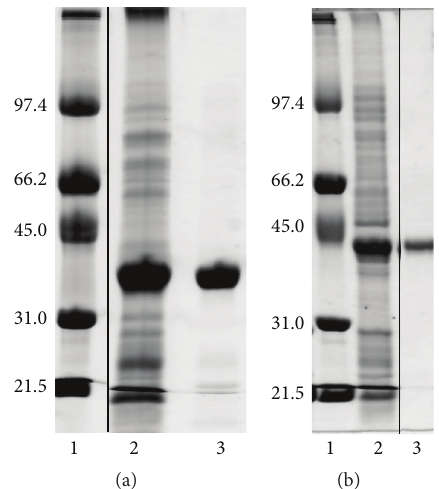
Figure 3: Purification samples of PeiW and PeiP on SDS-PAGE. Gel (a) PeiW; lane 1, molecular weight markers with sizes indicated in kDa, lane 2, PeiW crude lysate supernatant, and lane 3, PeiW after nickel-affinity chromatography step. Gel (b) PeiP; lane 1, molecular weight markers with sizes indicated in kDa, lane 2, PeiP crude lysate supernatant, and lane 3, PeiP after desalting step. A vertical line in each gel indicates the removal of irrelevant lanes.